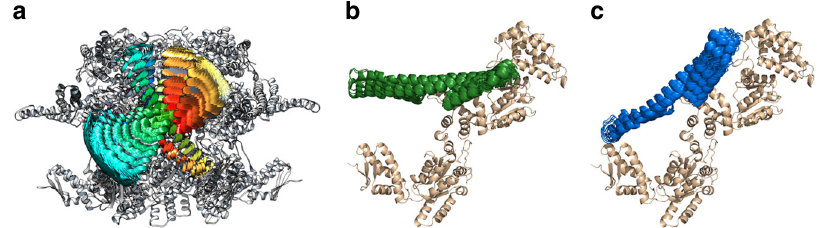
Fig. 2 Obtaining a structural model for the M-domain conformations. a A cartoon showing all allowed conformations of the M domain (shown in rainbow color), superimposed on the hexamer structure (gray), which is modeled on the basis of the crystal structure of the ClpB monomer 53 . b , c M-domain conformation in state 2 (( b ), shown in green), and state 1 (( c ), shown in blue). Shown are the 10 conformations with the lowest chi-squared values as obtained from our calculation (see Methods). The predicted FRET ef fi ciency values corresponding to each structure were calculated taking the dye linkers into account 49,50 . See Supplementary Table 3 for further analysis of the best structures and Methods for the calculation procedure. Source data are provided as a Source Data fi